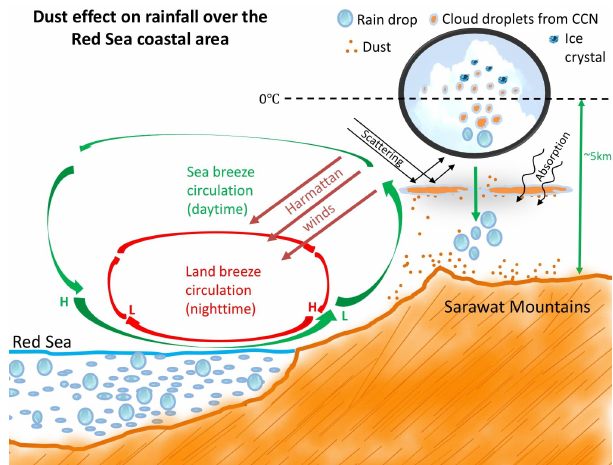
Figure 15. Schematic diagram representing the rainfall processes and dust–rainfall interactions over the Red Sea